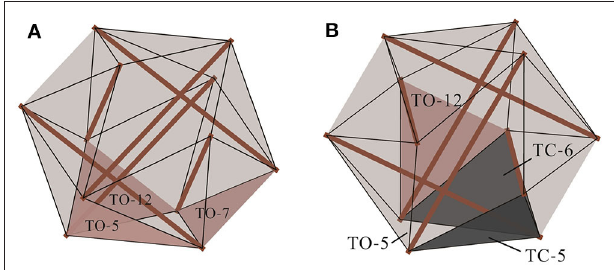
FIGURE 7 | Two initial states: (A) TC state and (B ) TO state.